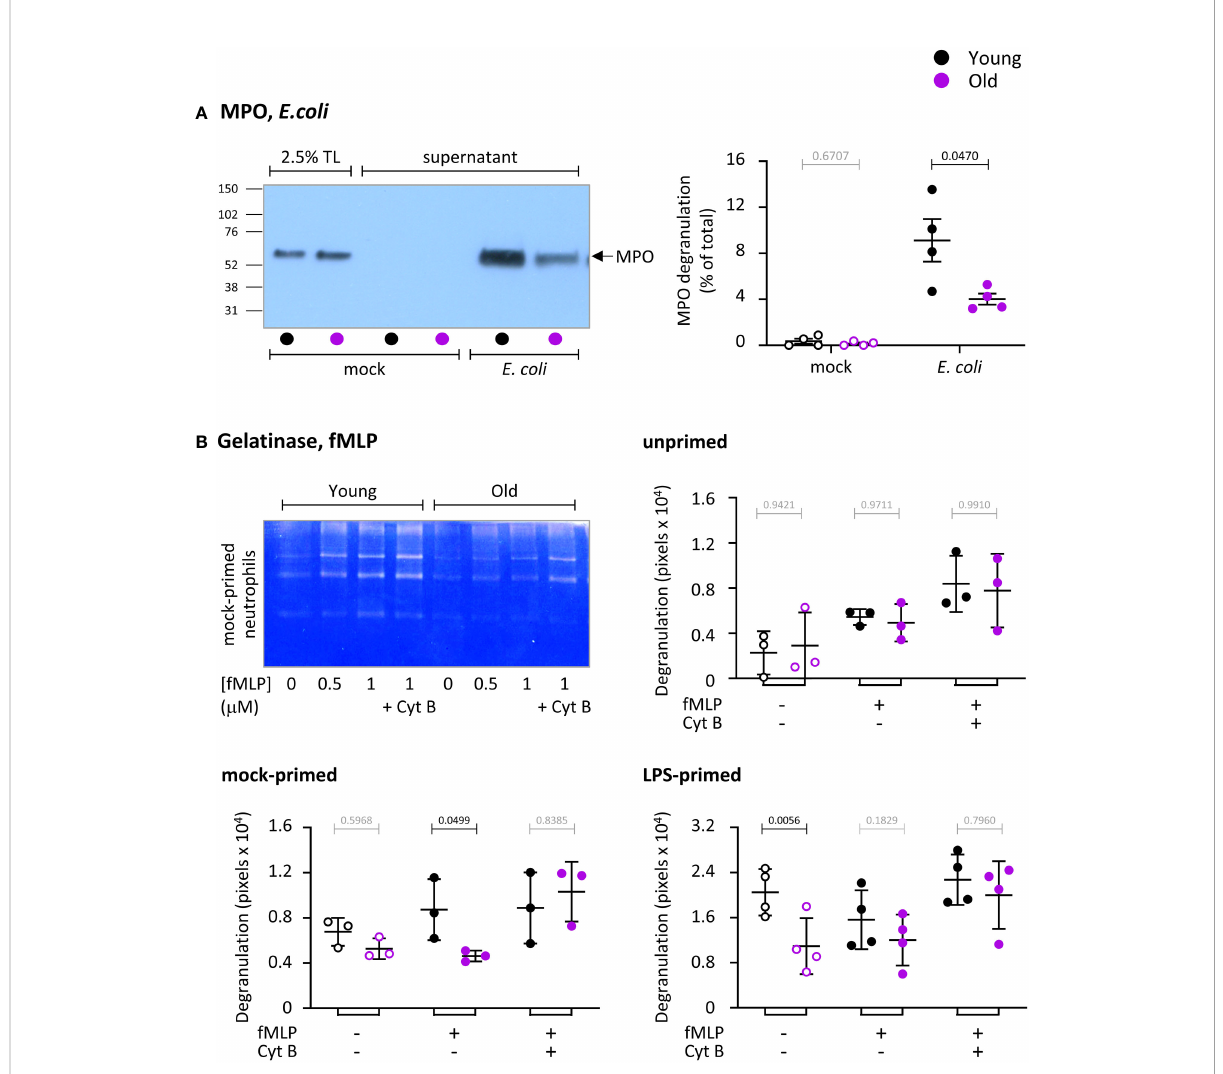
FIGURE 4 Hornigold K et al. Degranulation is impaired in neutrophils from old mice, in part through effects of LPS. (A) Degranulation of azurophil granules in response to E.coli . Neutrophils from young (8-10 weeks, black symbols) and old (24 months, purple symbols) mice were stimulated with E. coli (ratio of 12.5:1 bacteria/neutrophil; closed symbols), or were mock-stimulated with DBPS ++++ (open symbols), for 3 h at 37°C. Cell pellets and cell supernatants were collected and western blotted for the azurophil granule marker MPO. Degranulation was quantitated by comparing secreted MPO to total MPO in the 0 ’ total lysate (TL) control. (B) Degranulation of gelatinase granules in response to fMLP. Neutrophils from young and old mice were kept unprimed on ice, or mock-primed at 37°C for 45 min, or primed with 1 m g/ml LPS for 90 min at 37°C, as indicated, and were then either mock-stimulated (open symbols), or stimulated with 1 m M fMLP, or with both 1 m M fMLP and 10 m M cytochalasin B (closed symbols) for 30 min at 37°C. Gelatinase activity released into the medium was analyzed by in-gel zymography. The representative coomassie-stained gel of mock-primed cells from one experiment shows the digestion of the gel by gelatinase as white areas. Quanti fi cation of gels was done by ImageJ densitometry. Data in (A) and (B) are mean ± SEM of 3-4 independent experiments, as indicated; each dot represents the mean of one experiment. Statistics are two-way ANOVA with Sidak ’ s multiple comparisons tests on log-transformed raw data; black p-values are signi fi cant, grey p-values non-signi fi